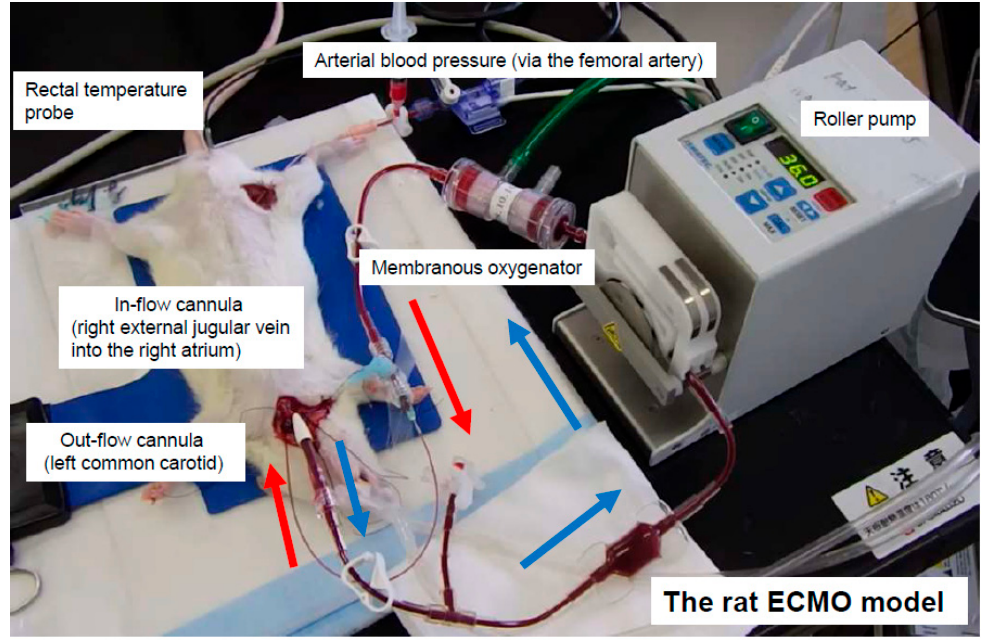
Figure 1. Extracorporeal circulation in a rat extracorporeal membrane oxygenation (ECMO) model.